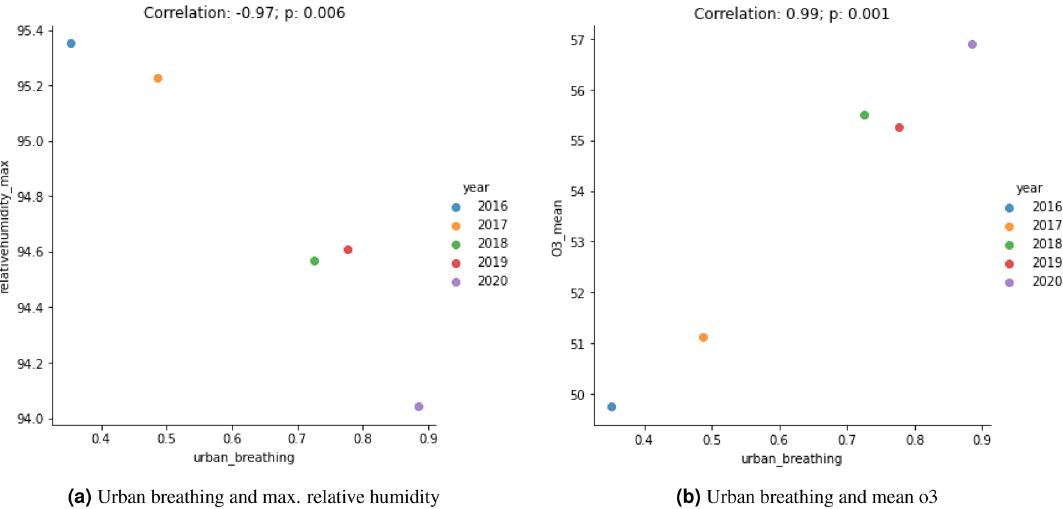
Figure 4. BB symptom urban breathing correlations with relative humidity ( a ) and mean O 3 ( b ), aggregated by